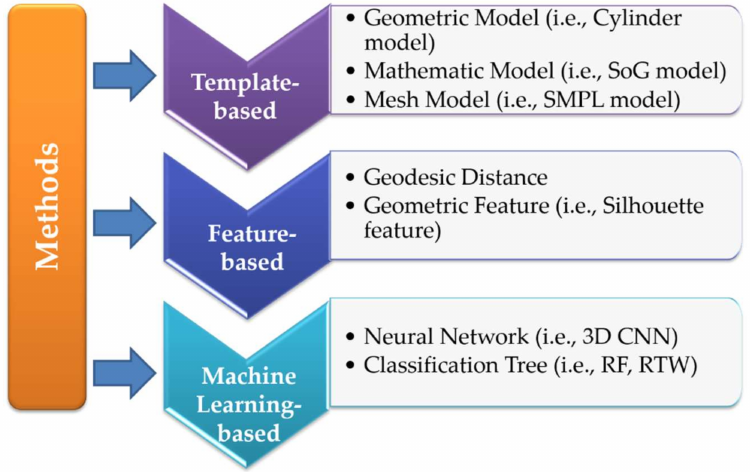
Figure 3. Categorization of the methods for the 3D joints extraction based on point cloud. SoG is sums of spatial gaussians; SMPL is skinned multi-person linear; CNN is convolutional neural network; RF is random forest; RTW is random tree walk.